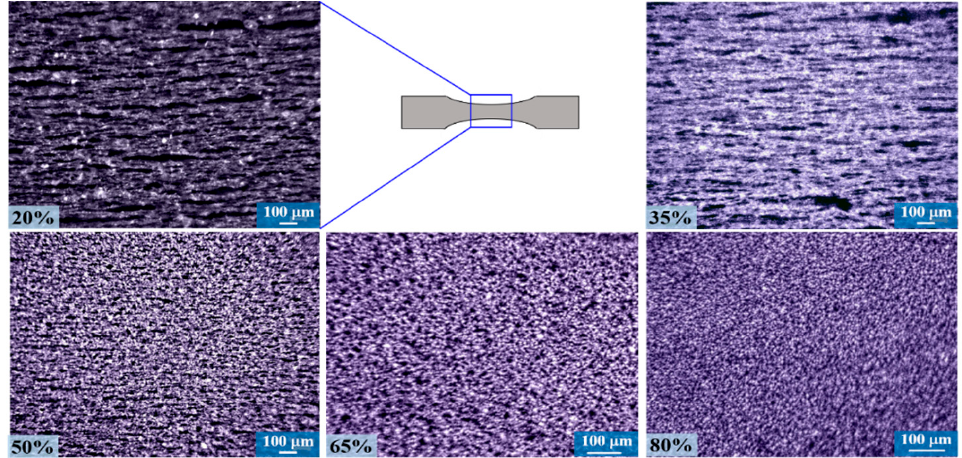
Figure 16. Images that show the alignment for an anisotropic sample of the CIPs inside the polyurethane (PU) matrix when subjected to a magnetic flux density of 52.2 mT.